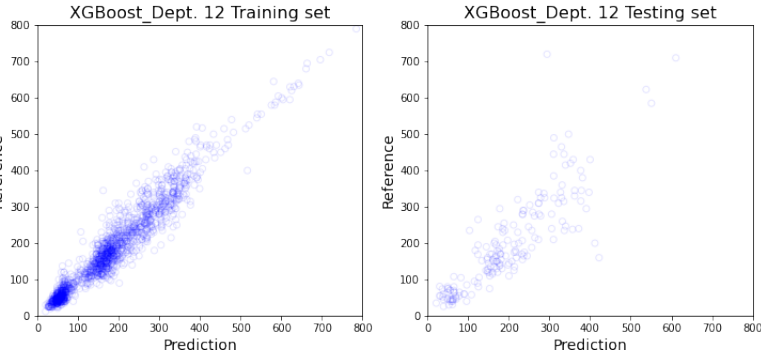
Figure A22. Model Performance of XGBoost on Dept.12. The visualization of training and testing data for department specific model on department 12 with